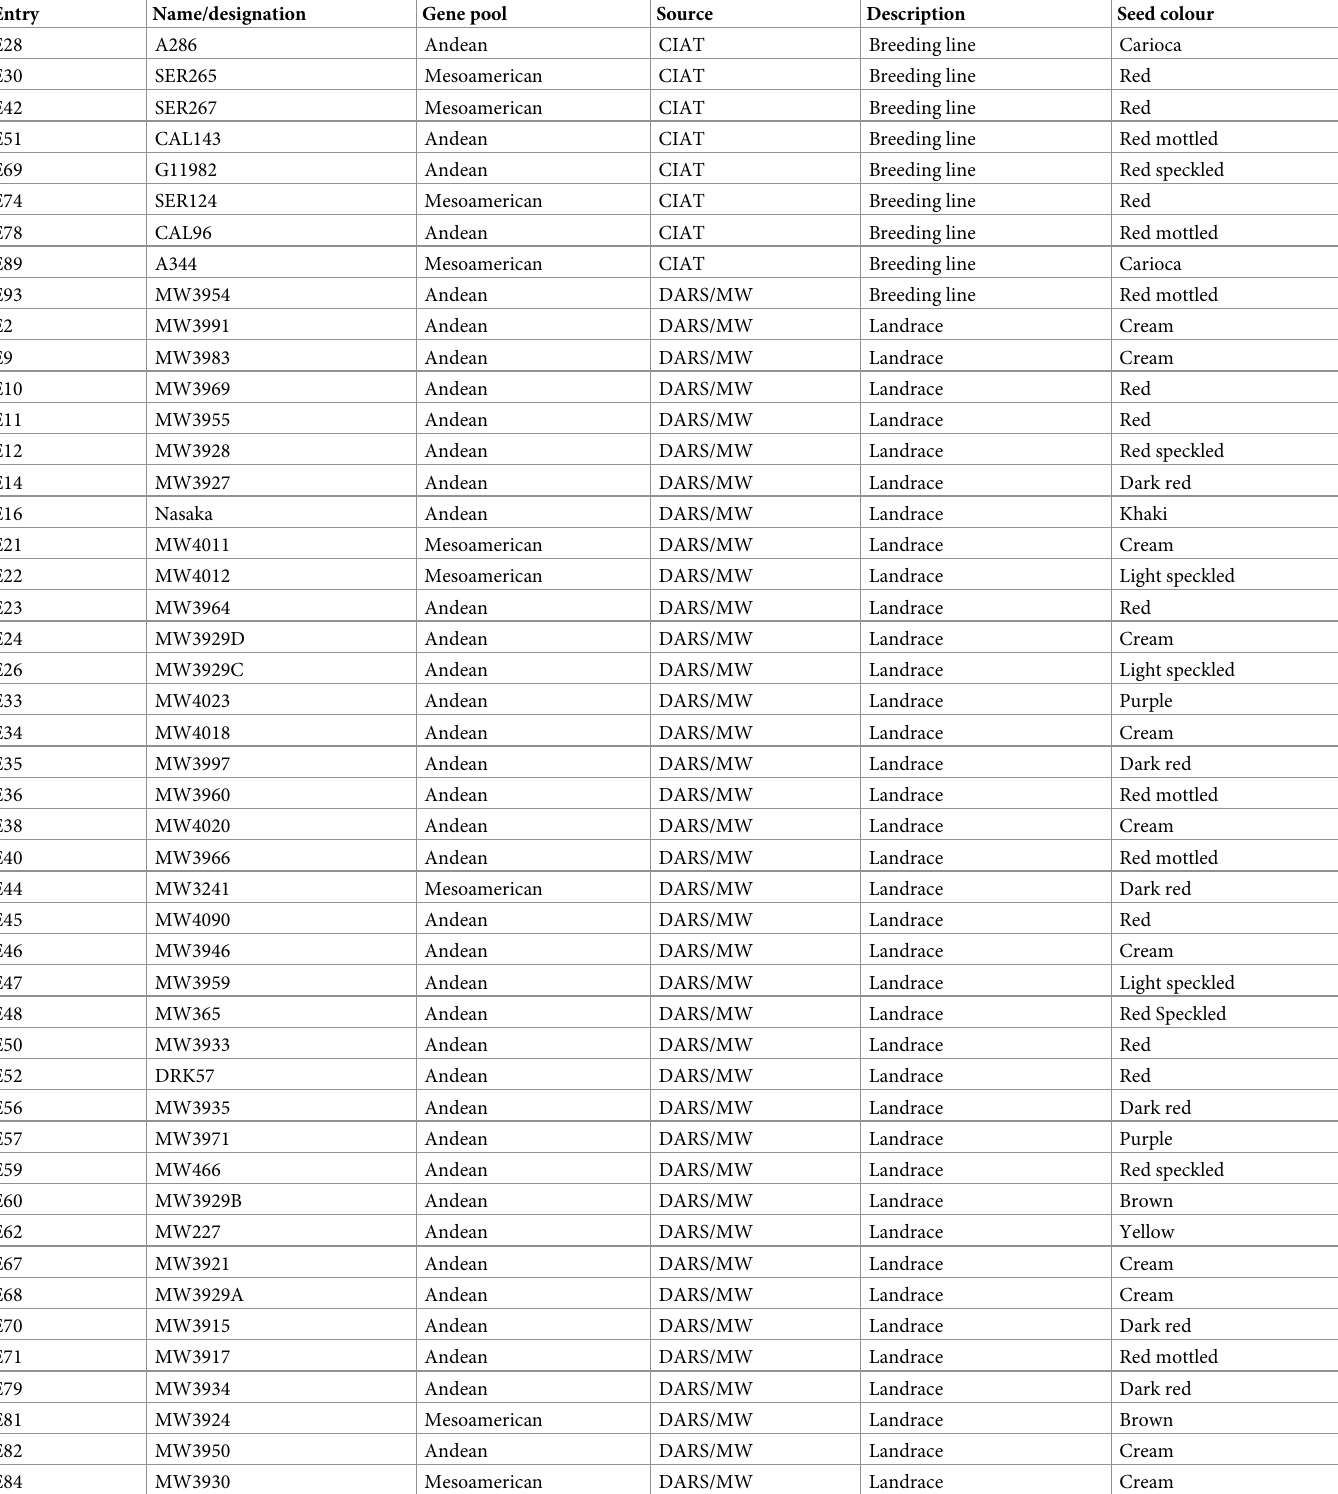
Table 1. Entry code, name, and description of 60 common bean genotypes used in the